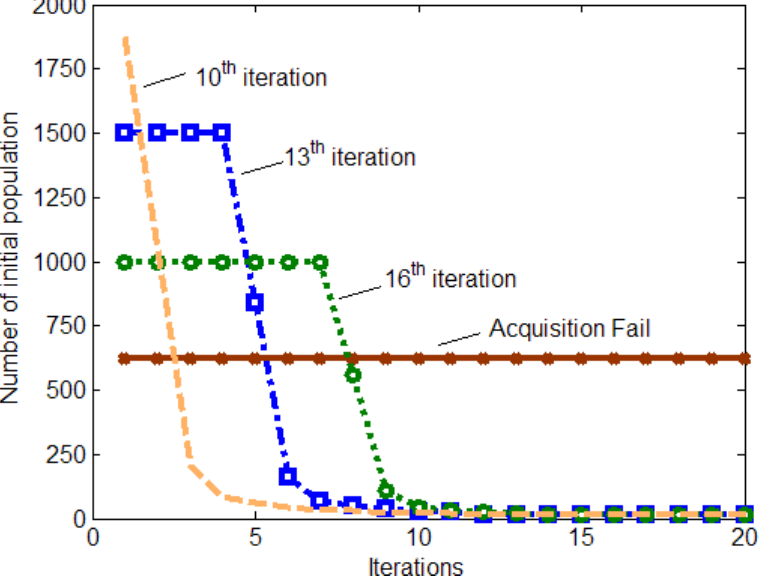
Figure 4. Number of initial population versus iteration (C/A-code; C/No = 45 dB-Hz).